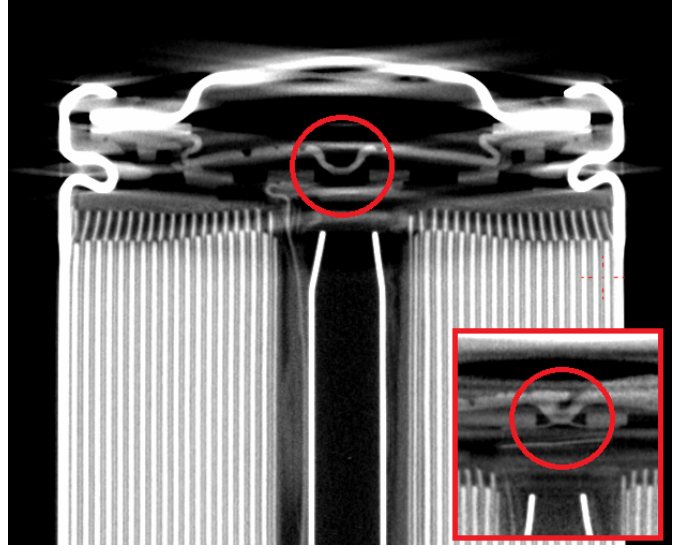
Figure 5. CT scan of the cell 1p5 with 0 V at the terminals. In the upper part, a triggered CID can be seen in the red circle. The non-triggered CID of the cell 1p3 for comparison is shown at the bottom